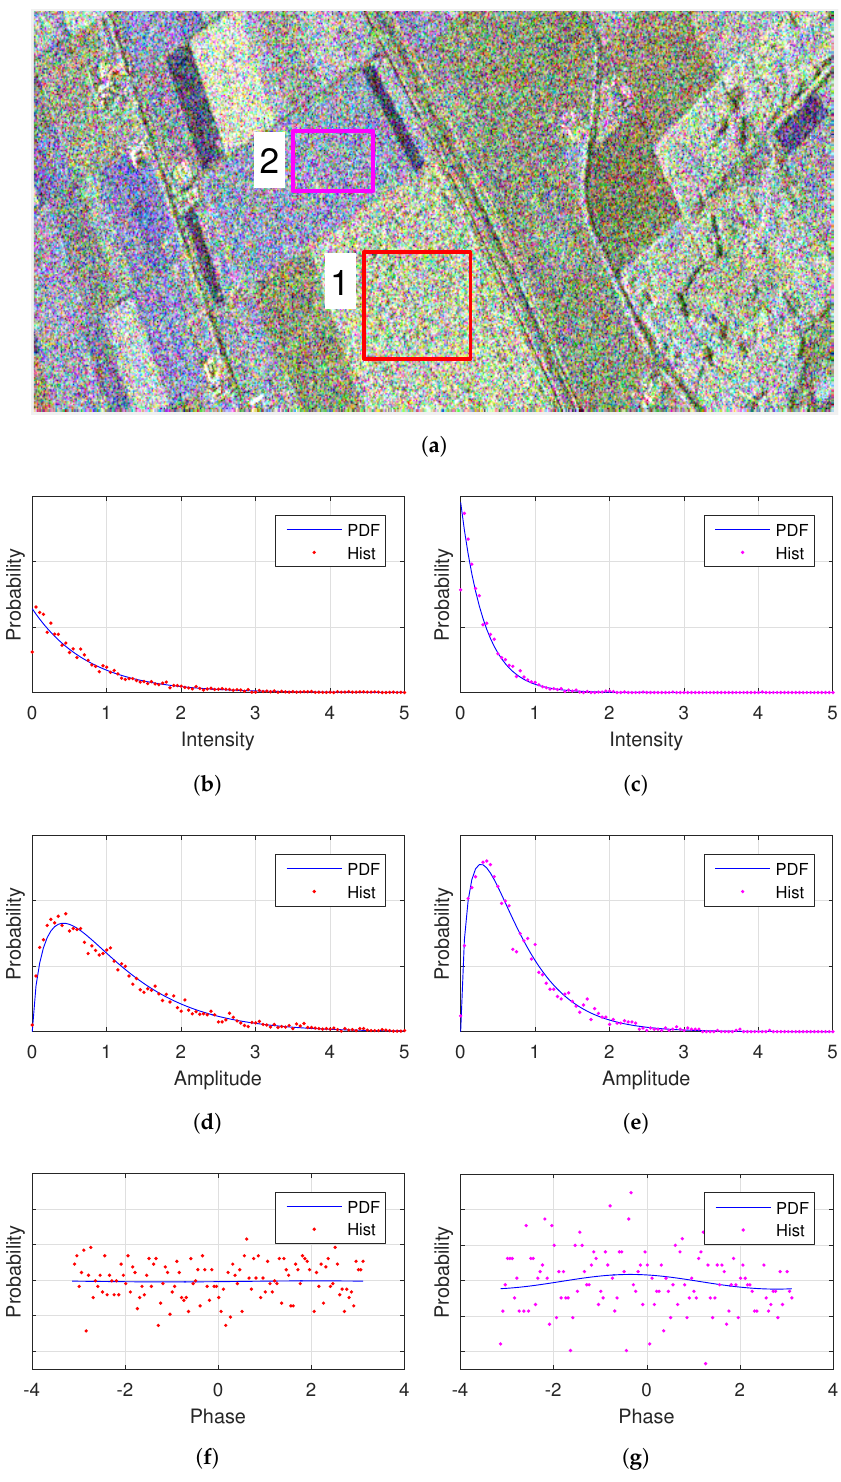
Figure 2. Histograms of two homogeneous areas in a RADARSAT-2 image and the PDFs under Gaussian assumption. Parameters of the Gaussian distributions are estimated using moments. ( a ) Pauli decomposition of the RADARSAT-2 data and two ROIs. ( b , c ) Intensity of the S hh . ( d , e ) Amplitude of S hh S hv . ( f , g ) Phase of S hh S hv